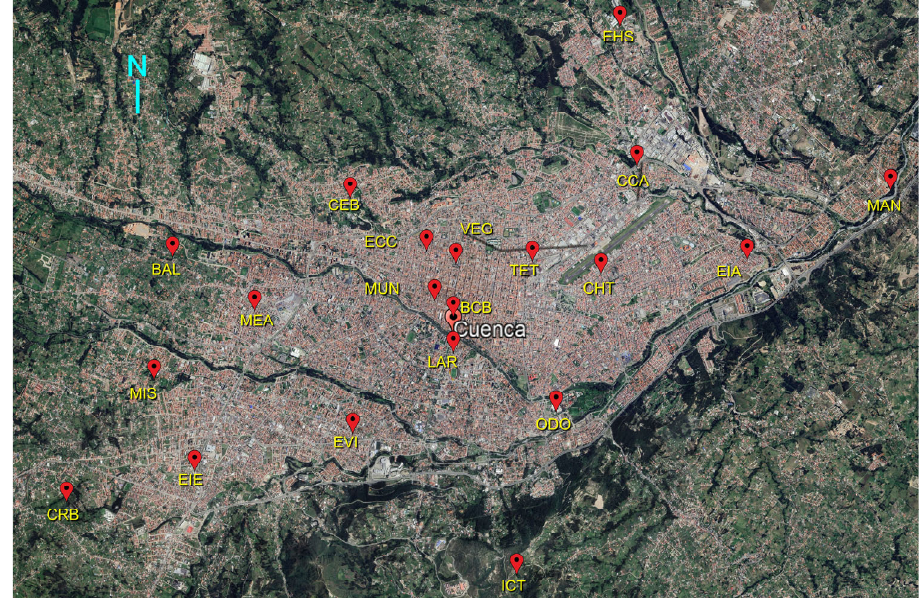
Figure 2. Map showing the location of the stations of the Basin Air Quality Monitoring Network ‐ Year 2021. The acronyms of the twenty monitoring points correspond to MAN (Machángara); EIA (Ignacio Andrade School); EHS (Héctor Sempertegui School); CHT (Herlinda Toral School); TET (Terminal Terrestre); ECC (Carlos Crespi School); ODO (Faculty of Dentistry ‐ University of Cuenca); EVI (Velasco Ibarra School); MEA (Mercado el Arenal); BAL (Balzay CEA ‐ University of Cuenca); CRB (Rafael Borja School); VEG (Vega Muñoz); CCA (Carlos Arizaga Vega School); MUN (Munici ‐ nas); CEB (Cebollar); and MIS (Misicata).